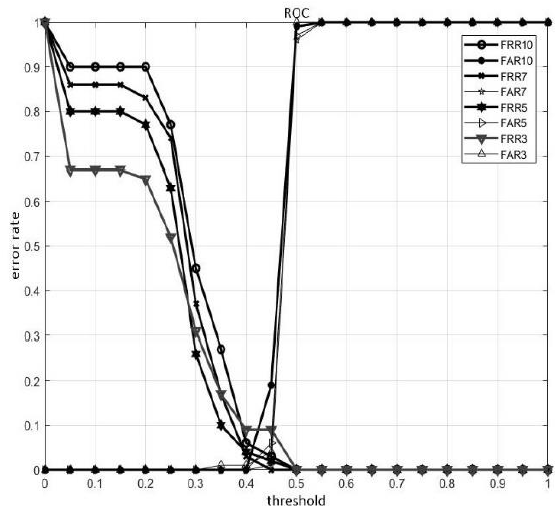
Figure 13. Curve ROC relateds to proposed method with regard to adoptions numbers (N= 3, 5, 7, 10).